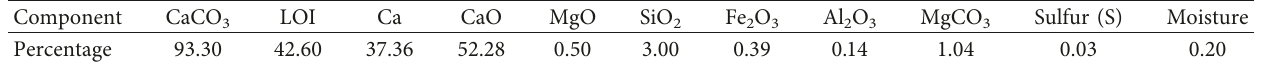
Table 1: Chemical composition of marble sludge.